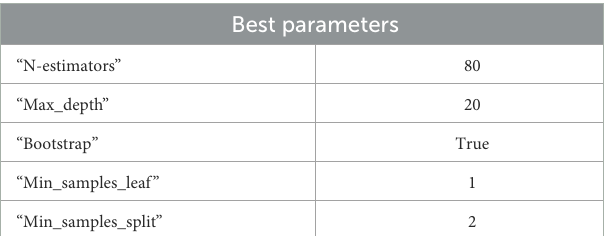
TABLE 1 Best parameters of the proposed model. Best parameters